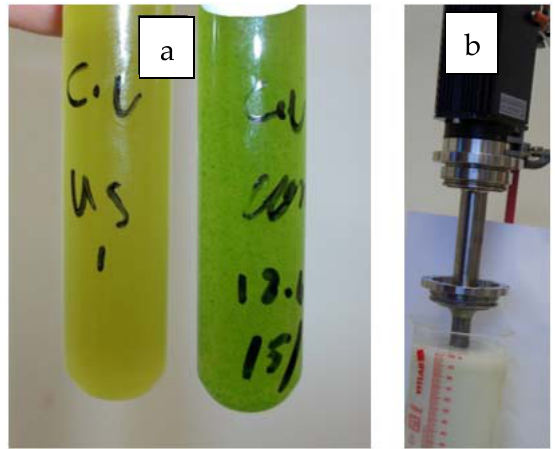
Figure 1. Samples of water containing FWM-CV ( a ), left sample treated with ultrasound, right sample un-treated. ( b ) Emulsified water in biodiesel and the ultrasound device.